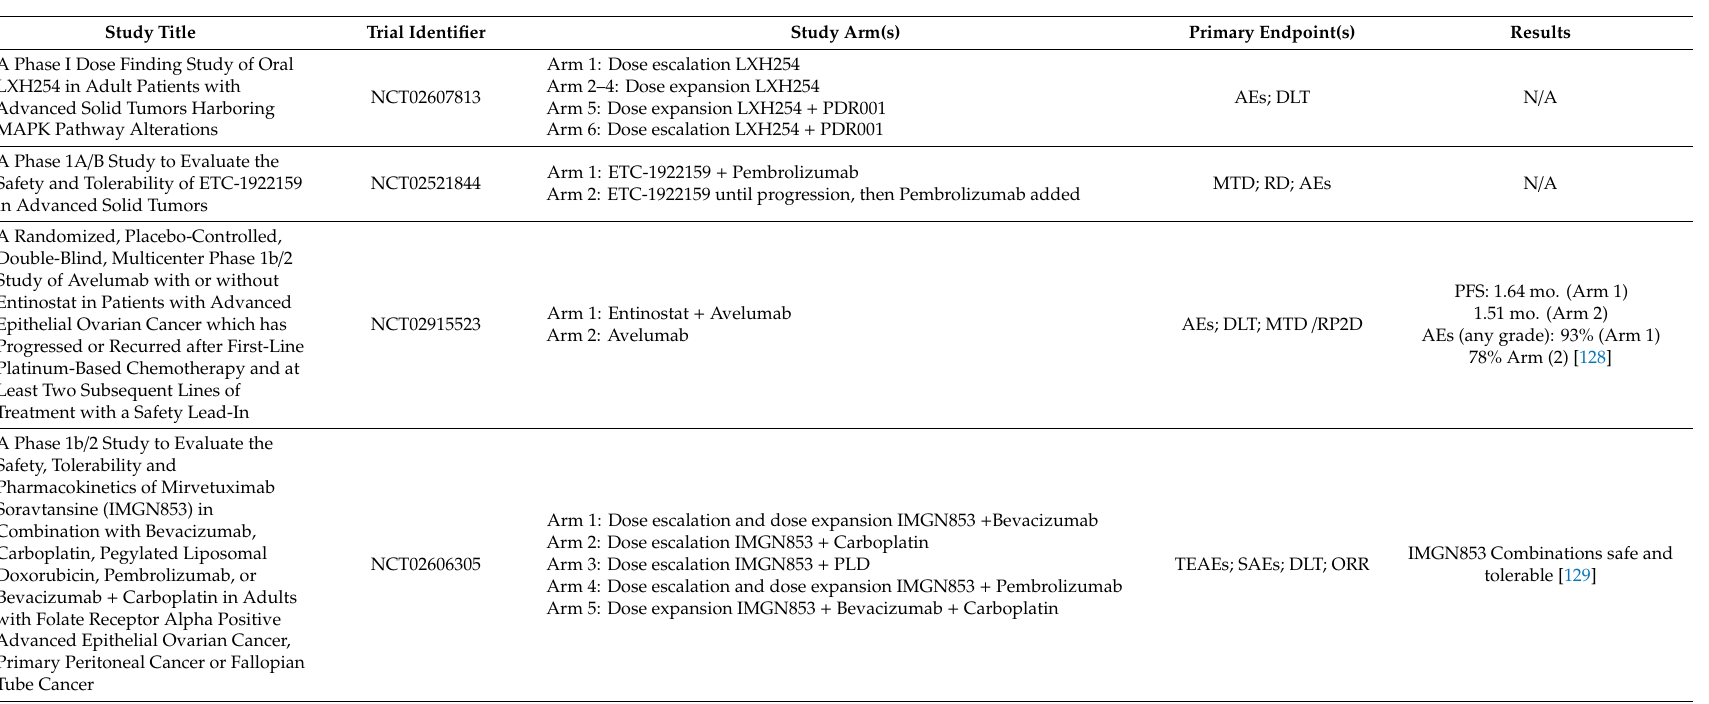
Table 6. PD-1 and other